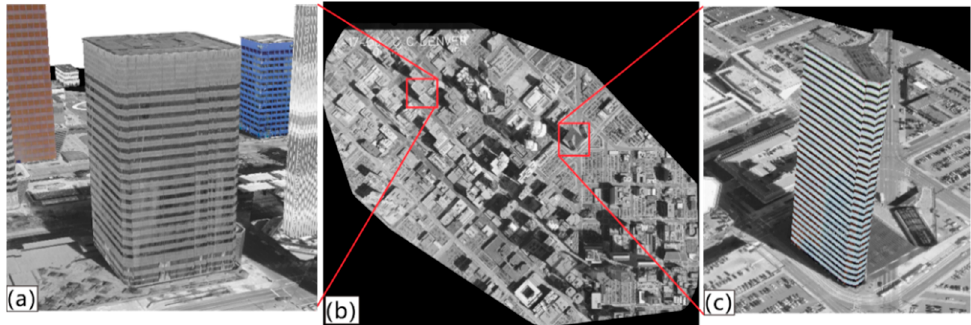
Figure 15. Merging DTM- and DBM-based T 2 OM on dataset 1. ( b ) T 2 OM; ( a , c ) are enlarged win- dows of the two regions. of the two